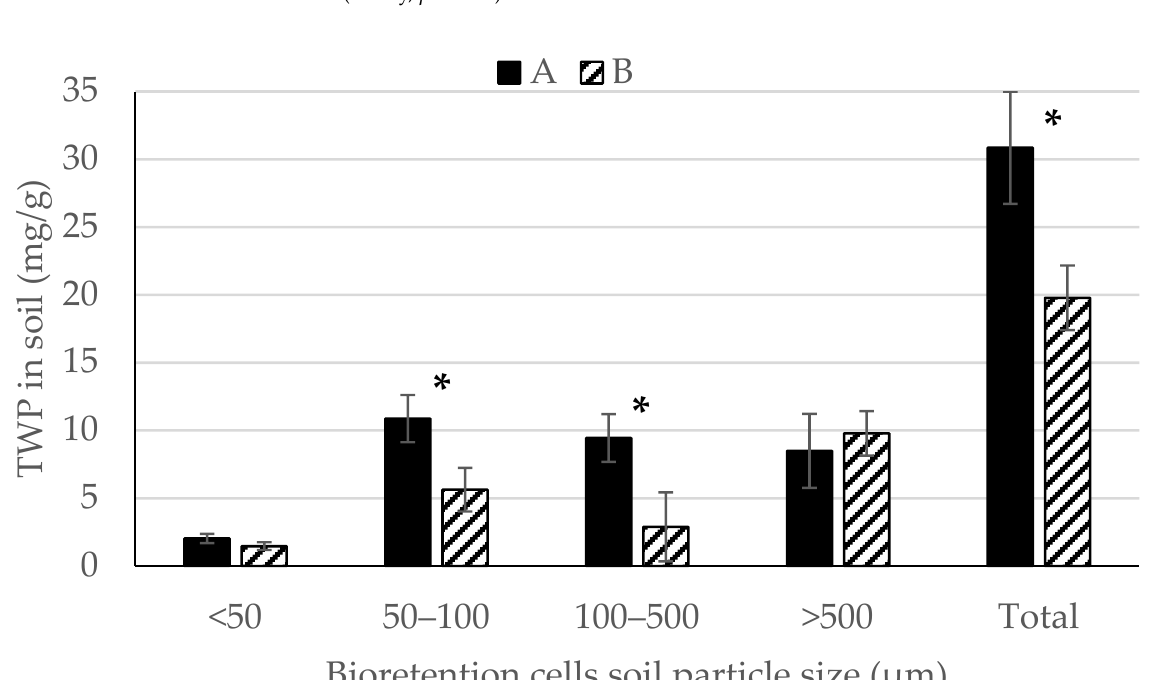
Figure 4. Tire wear particles (TWP) concentrations (mg/g, mean and one standard deviation, n = 3) factored by soil size proportion and total TWP concentrations in soil collected from a functional bioretention cell in Drammen, Norway, at the inlet (A), and 5 m away from it (B). Asterisks indicate significant differences between A and B ( t -test, p < 0.05).